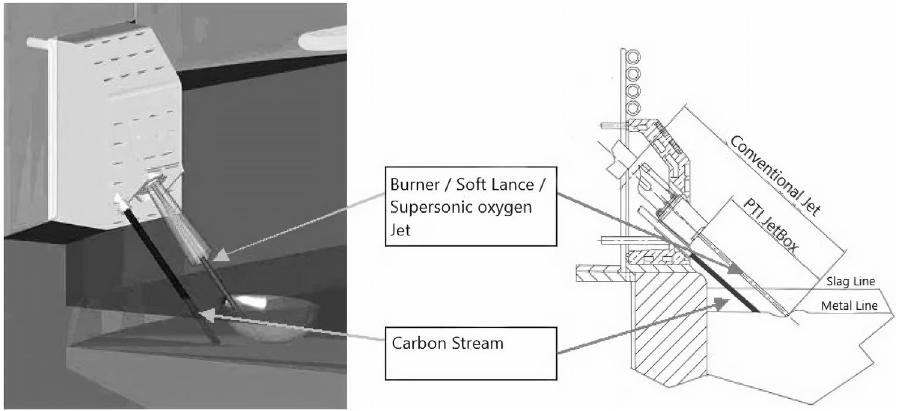
Fig. 14 Fig: Jet-box procedure